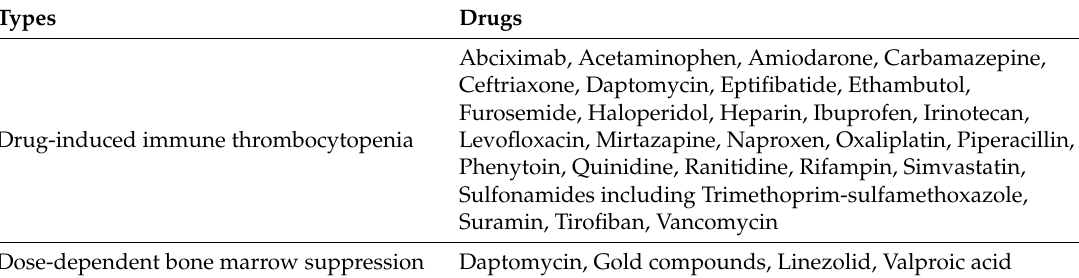
Table 1. Drugs associated with